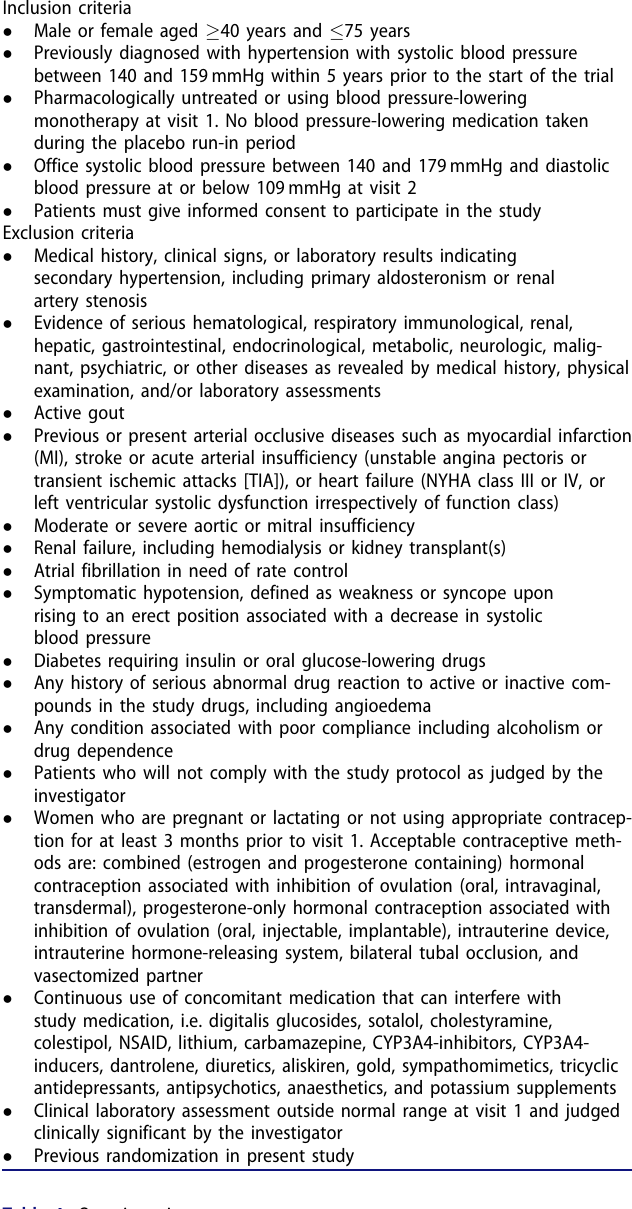
Table 3. Inclusion and exclusion criteria. Inclusion criteria (cid:3) Male or female aged (cid:2) 40 years and (cid:4) 75 years (cid:3)